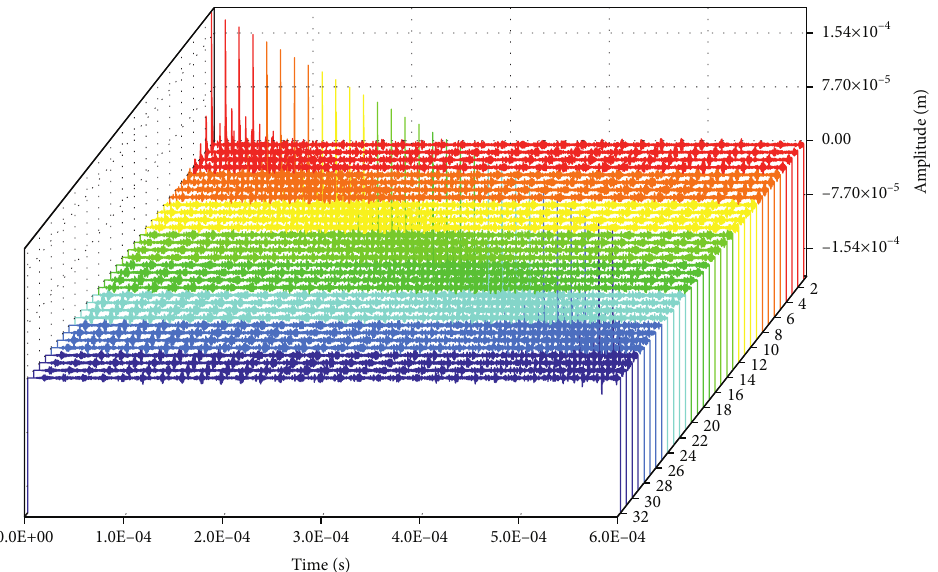
Figure 6: The captured full-matrix data of model